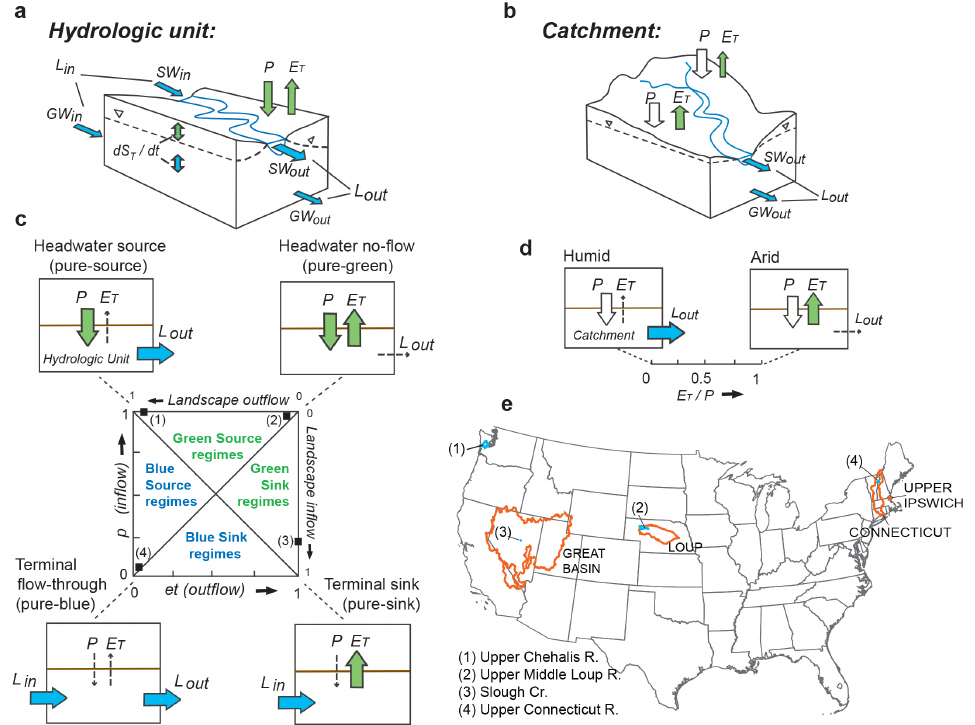
Figure 1. (a) Hydrologic unit, and (b) catchment, showing land–atmosphere (or green) fluxes (precipitation, evapotranspiration; P , E T ) and landscape (or blue) fluxes (groundwater + surface-water flows; L in , L out ) at boundaries. Double arrows show change in green (unsat- urated) and blue (saturated) storage; their sum equals change in total water storage (d S T / d t ) during a time step of interest. Catchment P influxes, defined by Falkenmark and Rockström (2004) as undifferentiated (neither green nor blue), indicated by white arrows. Internal soil moisture/ groundwater/surface-water exchanges not shown. (c) Hydroclimatic regime for a hydrologic unit is defined by the 2-D, (et, p ) plotting position on central regime space; see Table 2 for et and p definitions. End-member regimes shown by sketches at corners of regime space. Example regimes: sites 1, 2, 3, and 4; see Table 1. (d) Catchment hydroclimatic regime, defined by the 1-D position on E T /P axis. (e) Location map for sites 1, 2, 3, and 4 (Table 1), and major basins (Sect. 4; Fig.